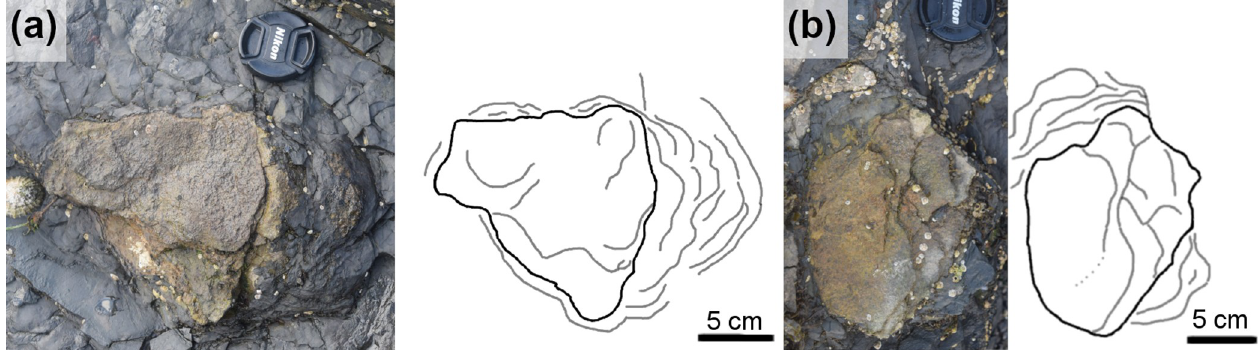
Fig 17. Eroded and in-filled casts observed at BP1. Examples of this track type can be seen with (a) BP1_21 and (b) BP1_22. These eroded casts are particularly abundant around the margins of the track-bearing platform. The track outlines are shown in black while soft-sediment deformation is illustrated in gray.